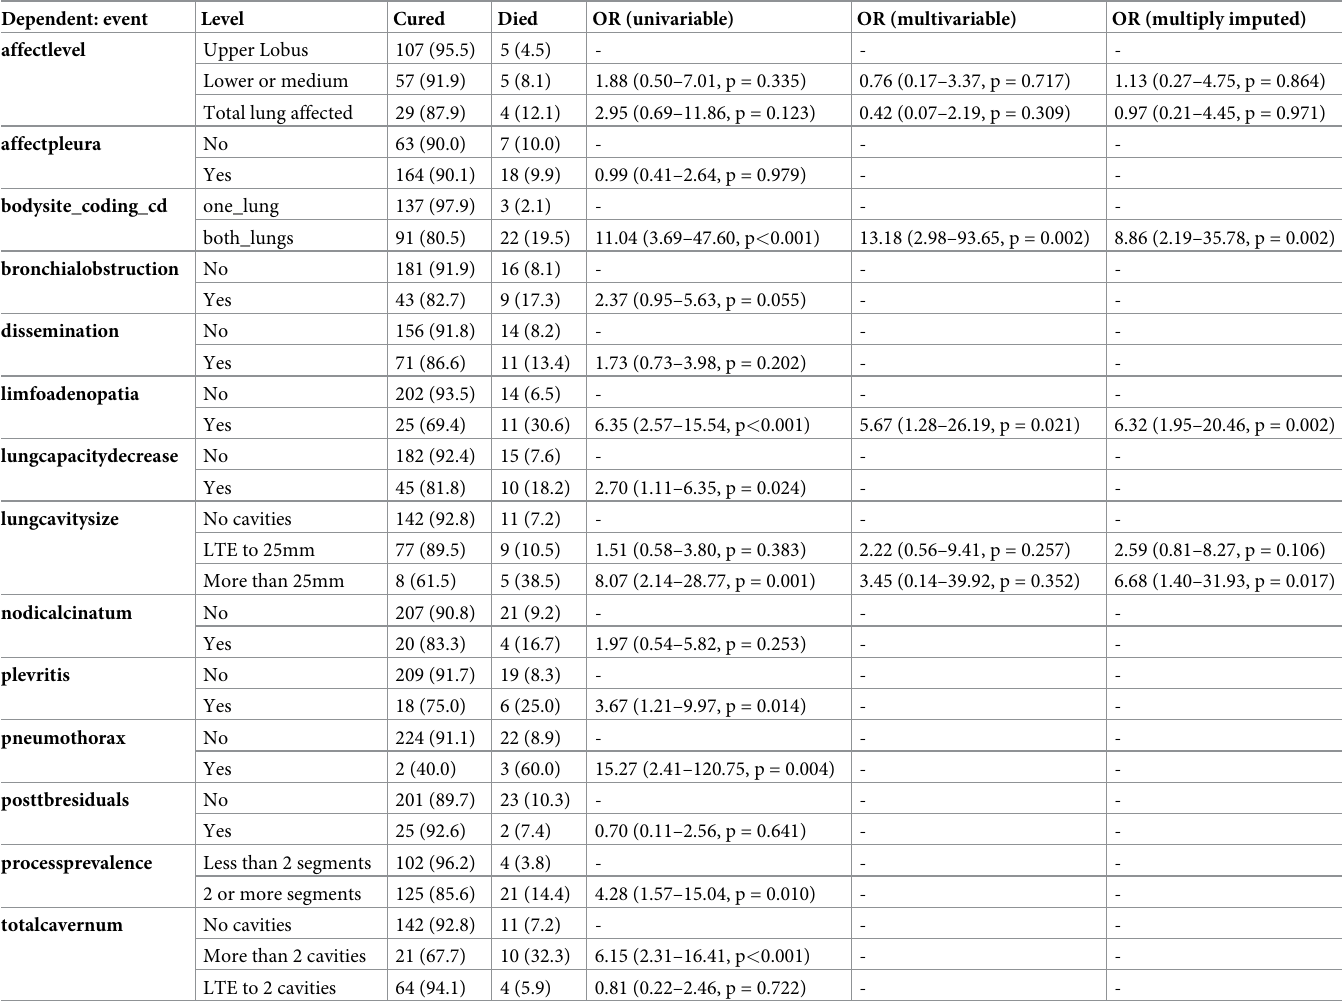
Table 1. Odds ratios from univariate, multivariate, and multiply imputed multivariate logistic